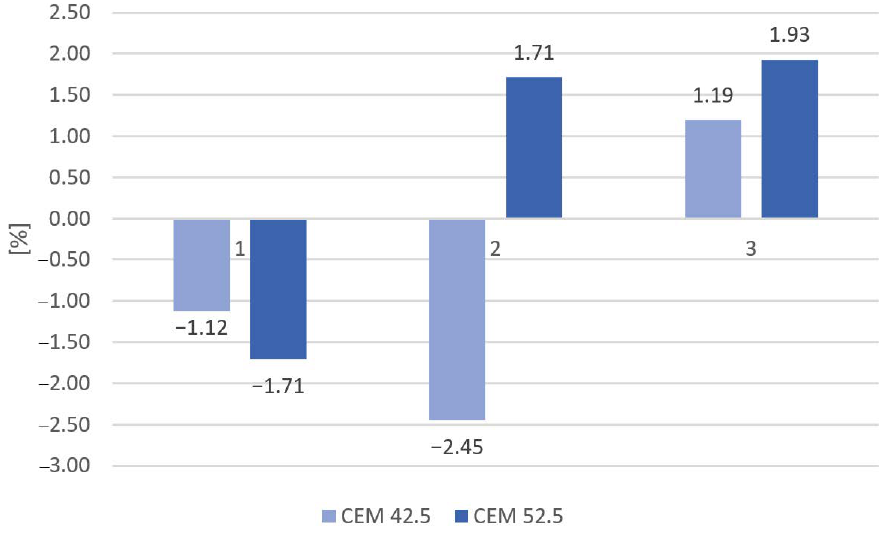
Figure 12. Percentage loss of mass after 150 cycles of frost resistance